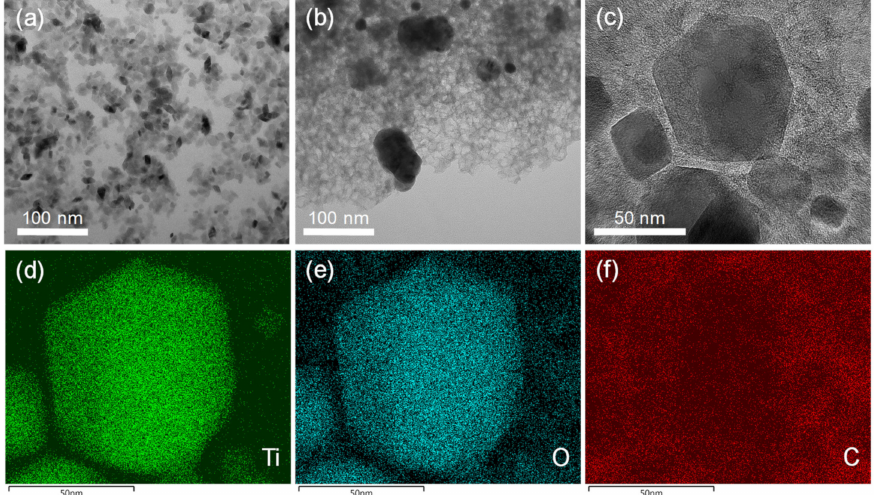
Figure 6. Transmission electron microscopy (TEM) images of ( a ) xer-TiO 2 and ( b ) TiO 2 / C-9-1. ( c ) High resolution TEM image and ( d – f ) STEM-EDX mapping of TiO 2 / C-9-1. The corresponding element (Ti, O or C) is noted in the bottom left corner of each